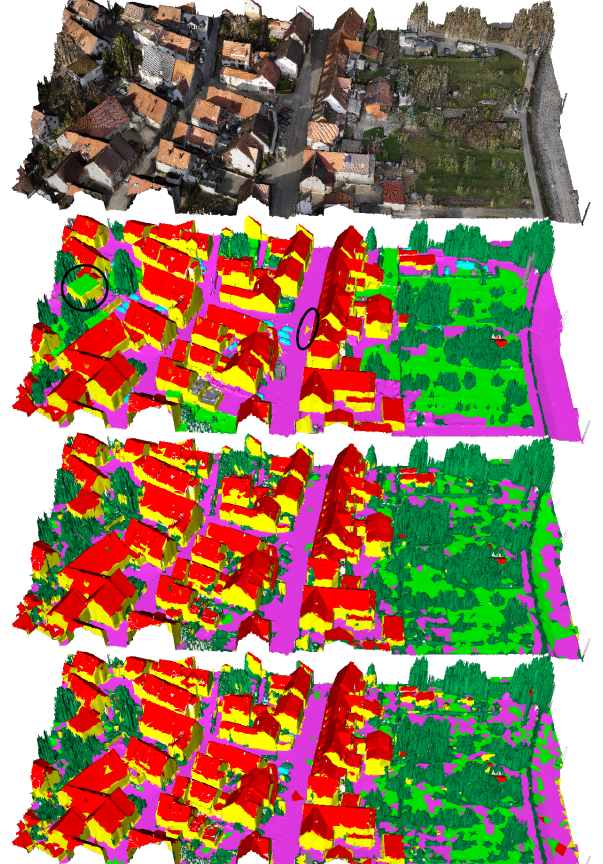
Figure 4. From top to bottom: Textured, ground truth labeled Tile A, RF prediction, 1D CNN prediction. In the ground truth you can see label noise: a flat roof ( black circle ) is labeled as green space and one face on the street is labeled as building mass/facade ( black ellipse ). Please note that the RF visually might indicate better performance on green space . Refer to Table 3 for actual results. Both classifiers consistently predict the actually correct label for the flat roof and have problems on the street.